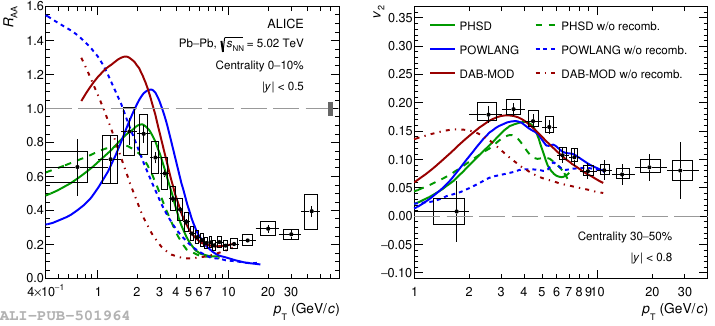
Figure 1. Left: p T -integrated R AA for D 0 mesons [1]. Right: R AA of Λ c compared with models [2].